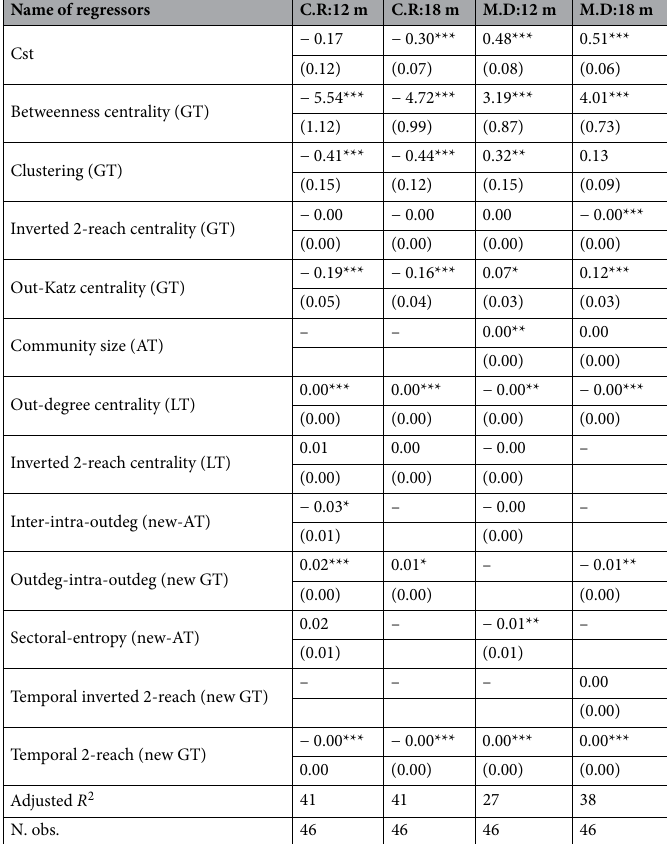
Table 4. Non-penalized multivariate regressions for system wide firm-based metrics, community-based metrics and community firm-based metrics. This table reports the cross-sectional regression of alternative measures of financial firms vulnerability on centrality measures selected in Table 3. The dependent variable is (i) the cumulative returns over 12 months in column 2, (ii) the cumulative returns over 18 months in column 3, (iii) the maximum drawdown over 12 months in column 4, (iv) the maximum drawdown over 18 months in column 5. Estimation is performed by ordinary least squares. Robust standard error are reported in parentheses. ***, **, * stand for statistical significance at 1%, 5% and 10%